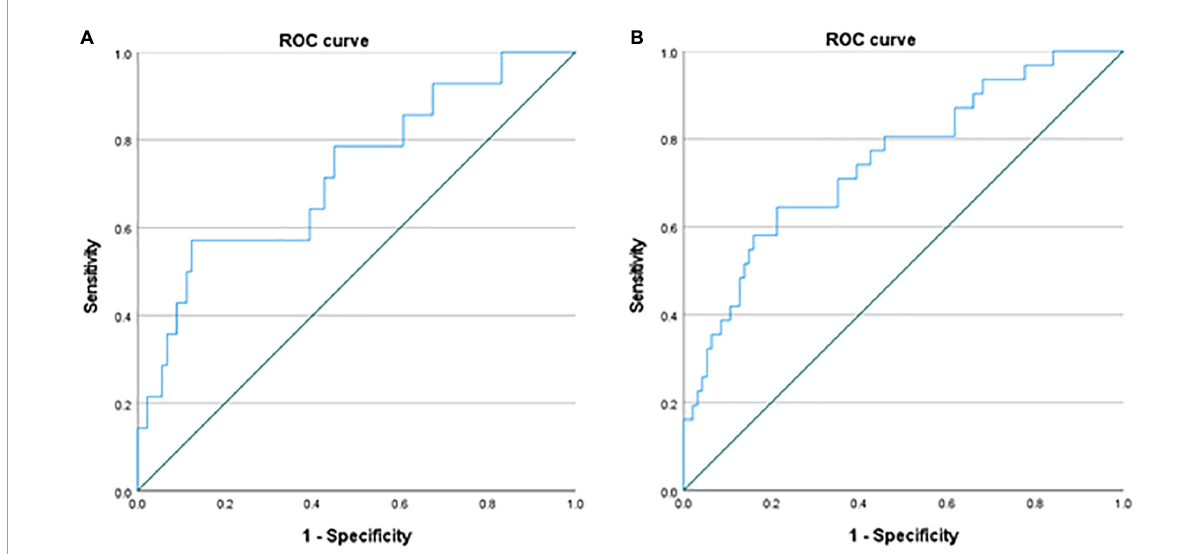
FIGURE2 Receiver Operating Characteristic (ROC) curves of the whole samples and the restoration group. There are two ROC curves of the whole sample for work restoration using a TMT-B completion time [ (A) upper figure; area under the curve (AUC) = 0.75, p < 0.001, cut-off point = 66.8 s] and the restoration group for work restoration [ (B) lower figure; AUC = 0.73, p = 0.007, cut-off point = 76.5